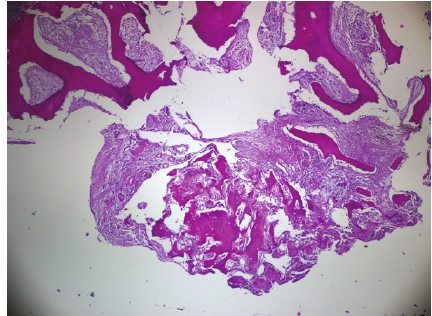
Figure 4: An osteoid osteoma nidus and the normal bone at the border of thelesion are demonstrated in thehistological section. The nidusiscomposedofvascularfibroustissueinwhichtherearesmall, irregular, but connected, trabeculae of woven bone, demonstrating both prominent osteoblasts and prominent osteoclasts (H and E, × 4